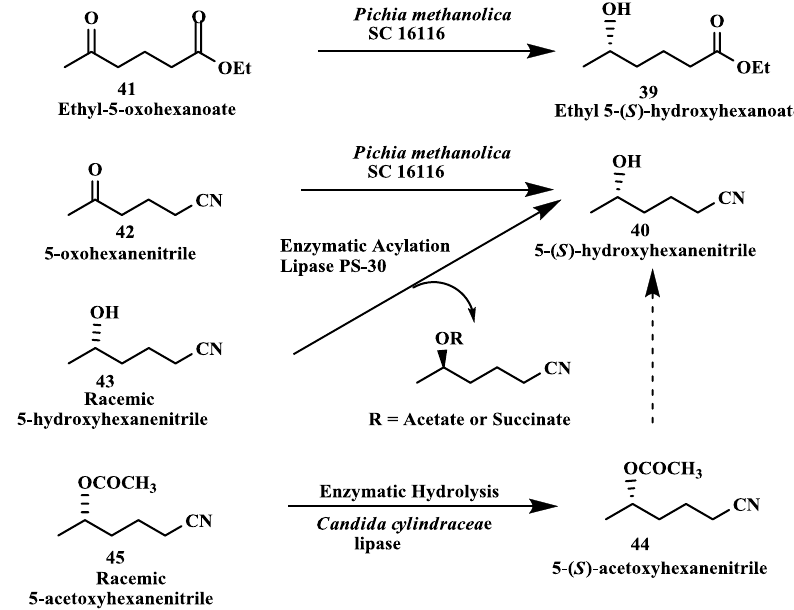
Figure 11. Anti-Alzheimer’s drugs: Enzymatic reduction of 5-oxohexanoate and 5-oxohexanenitrile.